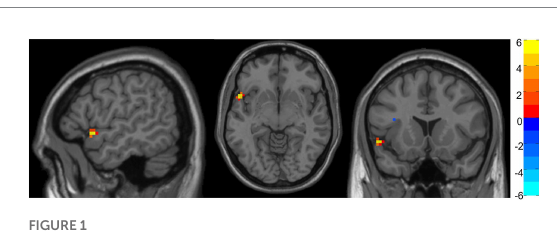
FIGURE 1 Representation of significant differences between Group 1 and Group 5 in fALFF analysis. The color bar indicates the intensity of the difference, with 6 (yellow) representing positive differences and − 6 (light blue) representing negative